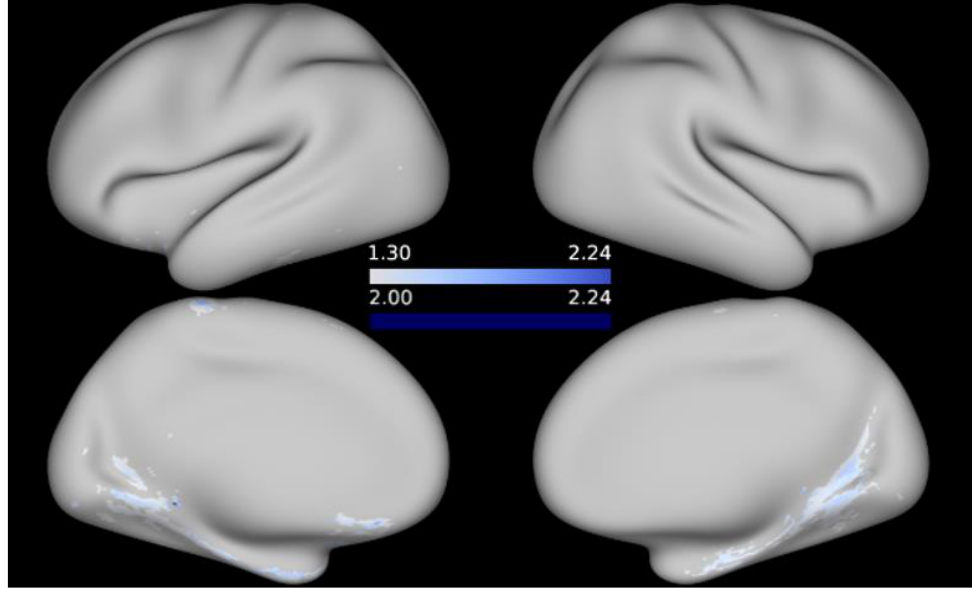
Figure 3. t -statistical map representing areas in which language ability was negatively associated with T1w/T2w contrast. Thresholded at − log10( p ) ≥ 1.3 (pale blue regions); p -values are uncorrected.